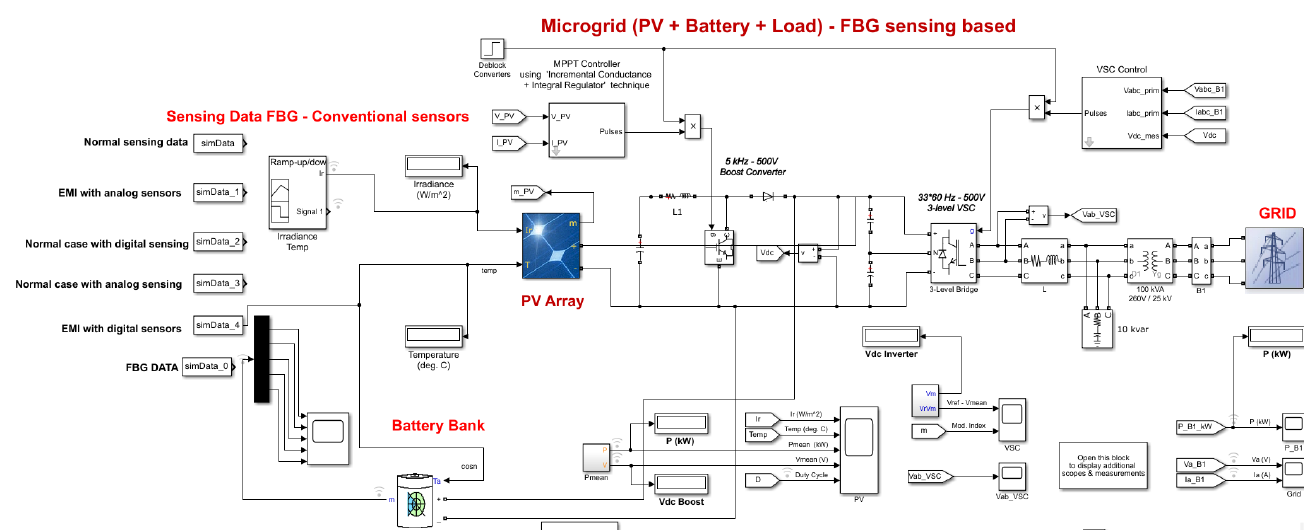
Figure 12. Applying the measurements of sensor reading on the